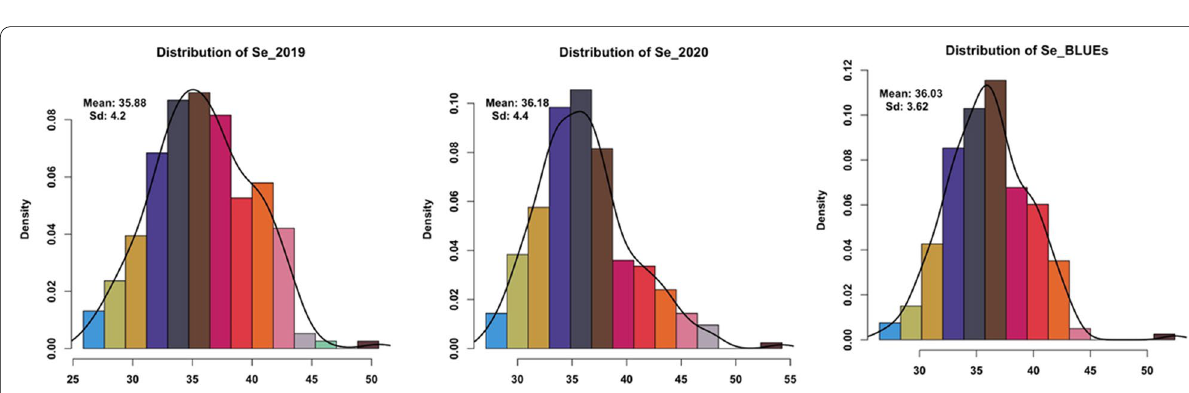
Fig. 4 Distribution of phenotypic data in all genotypes for Se concentration for each year (2019/2020) and BLUEs in spring